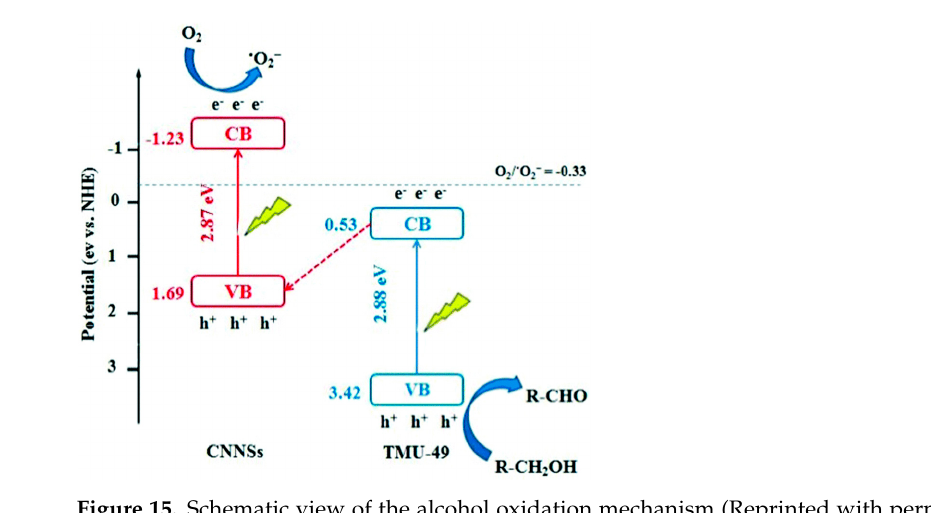
Table 4. Examples of Co-based MOFs used in the photocatalytic oxidation of various organic com- pounds.